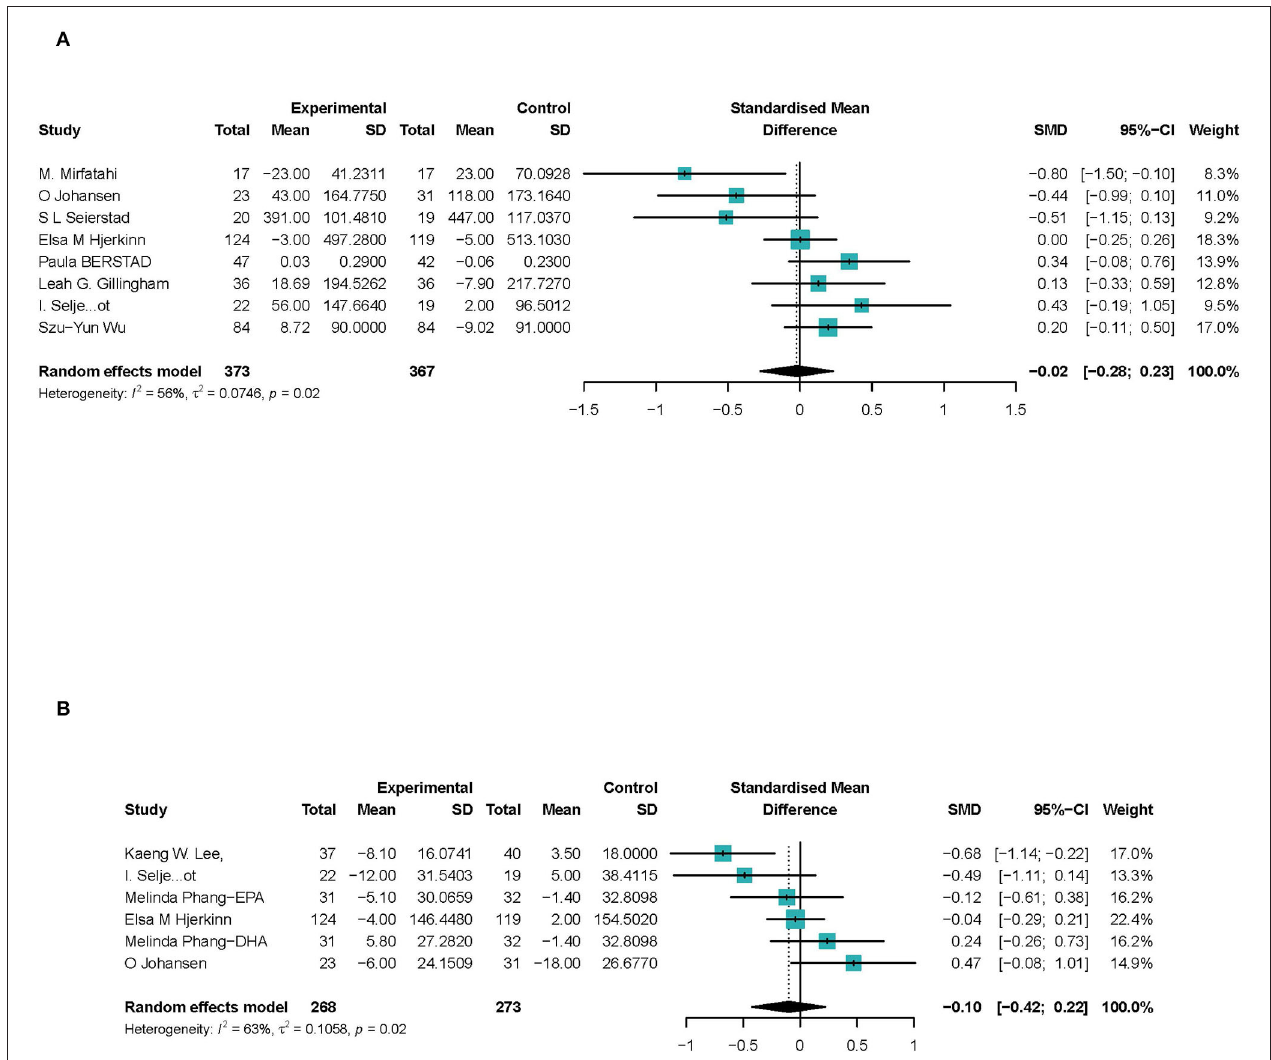
FIGURE 6 | Forest plots of associations of ω -3 PUFAs and endothelial cell markers. (A) sVCAM-1; (B) VWF%. Point sizes are an inverse function of the precision of the estimates, and bars correspond to 95% CIs. Data are calculated using a random-effect